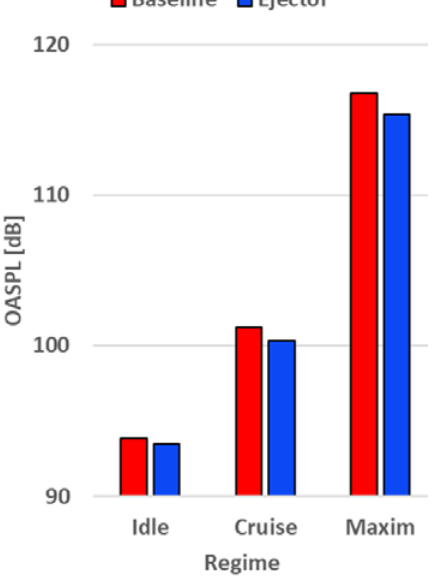
Figure 24. Averaged OASPL variation depending on the tested regime and nozzle configuration.